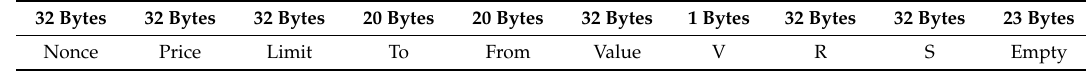
Table 2. Fields of transaction.